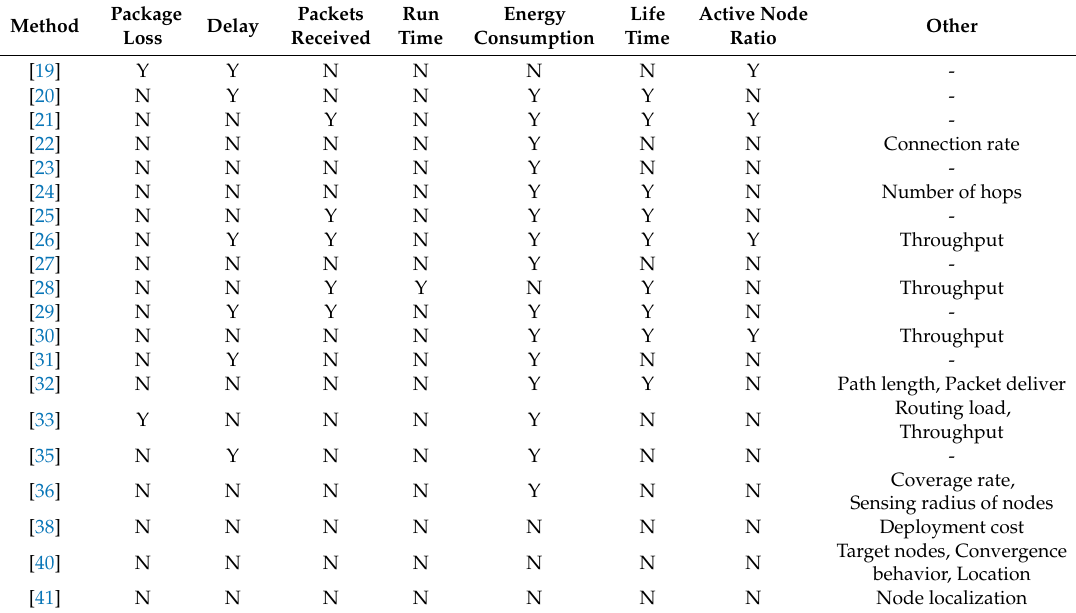
Table 5. Parameters to be considered in the validation of SI applications in